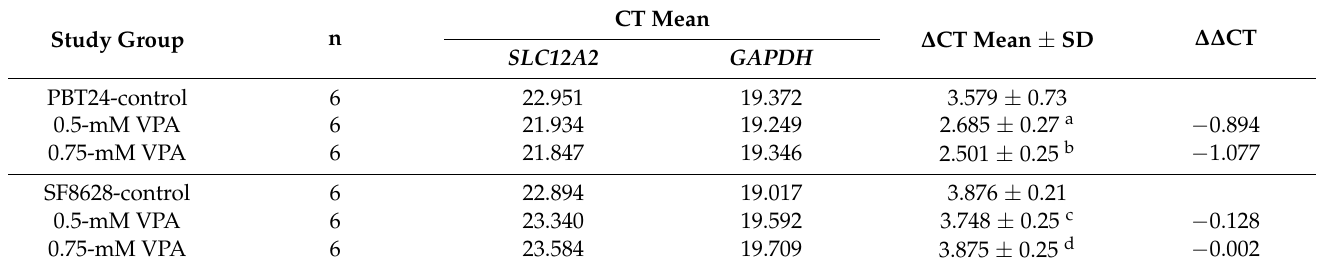
Table 1. RNA expression of SLC12A2 in PBT24 and SF8628 cell study